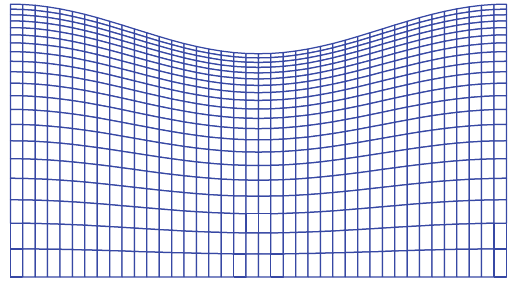
Figure 3: Finite element discretization of liquid